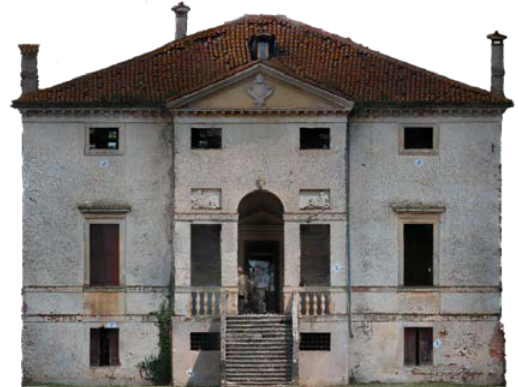
Figure 5. The study case: the main façade of Villa Forni Cerato, in Montecchio Precalcino, Vicenza. The orthophoto has a GSD of 0.004 m. The orthophoto elaborated from UAV